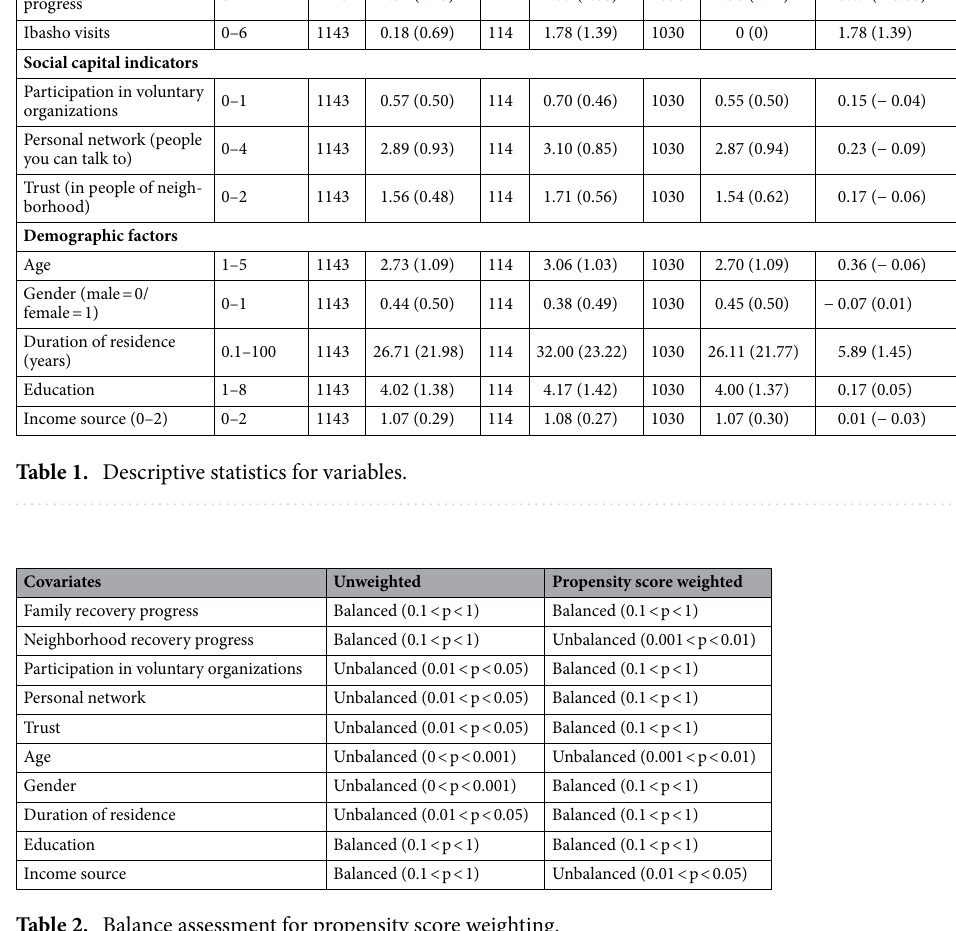
on the propensity score, the resulting groups have similar characteristics to randomly assigned groups in an experiment 39 . Table 2 reports the results of covariate balance tests. The balance for each covariate was tested by regressing each covariate on treatment (Ibasho visit = 1/0) [for details, see Ref. 38 ]. Covariates were reported as unbalanced if the coefficients were statistically significant (p < 0.05) and balanced if the coefficients were not significant (p > 0.05). As the table shows, propensity score weighting improved the balance for most variables, but neighborhood recovery progress, age, and income source variables became or remained unbalanced after weighting. In addition to the PSM, we also carried out coarsened exact matching (CEM), as some scholars have criticized PSM of its bias and inefficiency 18 . For CEM, all observations are first temporarily coarsened and sorted into different bins based on the chosen variables (i.e., independent variables). Matching individuals are then found based on these bins; others are discarded. After having a new treatment group and a control group using PSM and CEM methods, we used ordinal logistic regression to report the results.